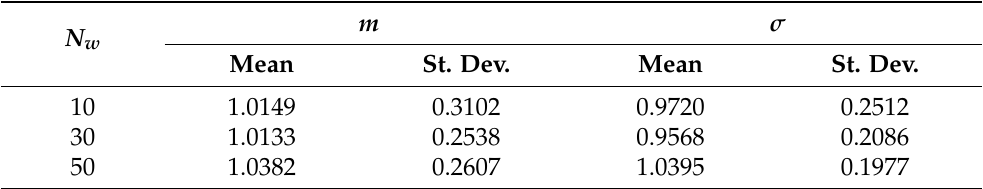
Table 1. Parameter estimates for the datasets with the cases N w = 10,30,50. The true parameter is set as m = 1, σ = 1. We present the mean and standard deviation of 30 repetitions for each case. m σ N w